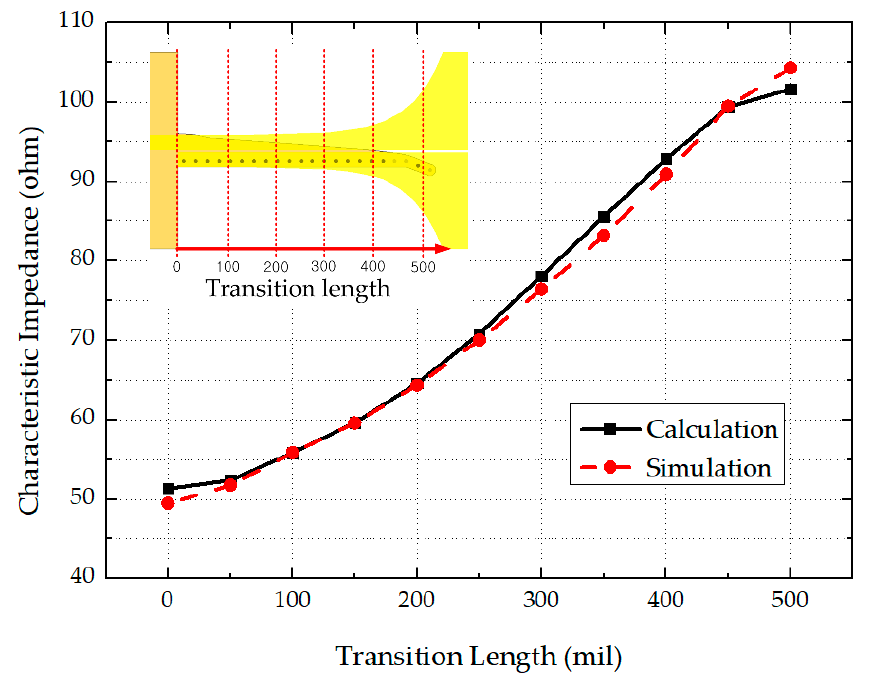
Figure 10. Characteristic line impedance along the transition length.